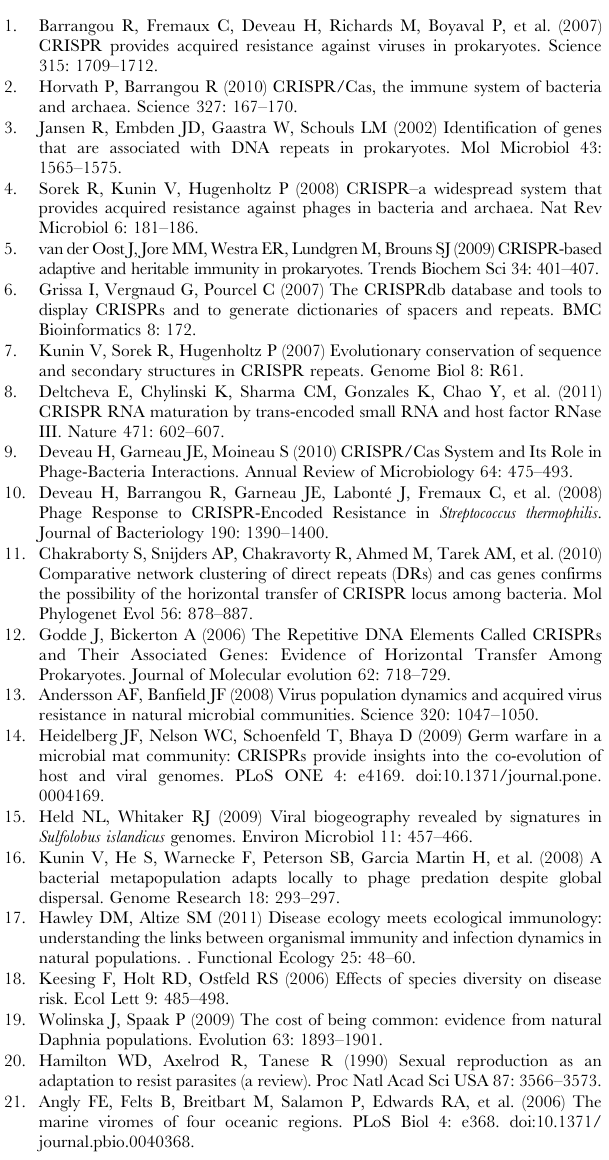
Table S6 List of plasmids sharing high sequence similarities ( $ 90%) with CRISPR spacers. Table S7 Targeted assembly results of 10 CRISPRs using reads simulated from 6